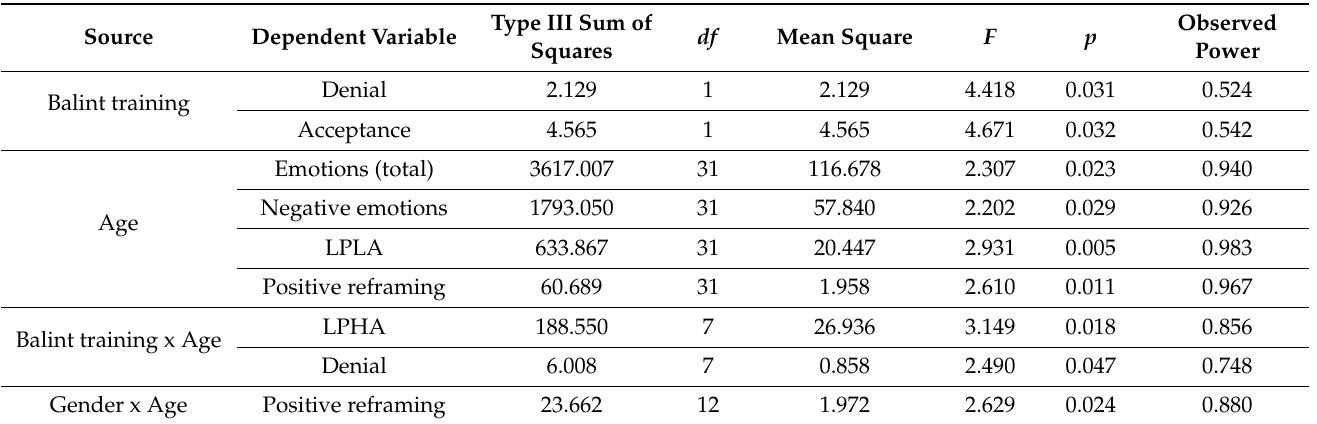
Table 3. Multivariate analysis of variance (MANOVA)